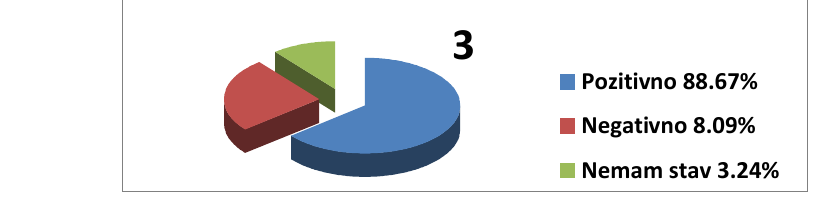
Figure 10 – The rating of the actions of the Ministry of Defence and the Serbian Armed